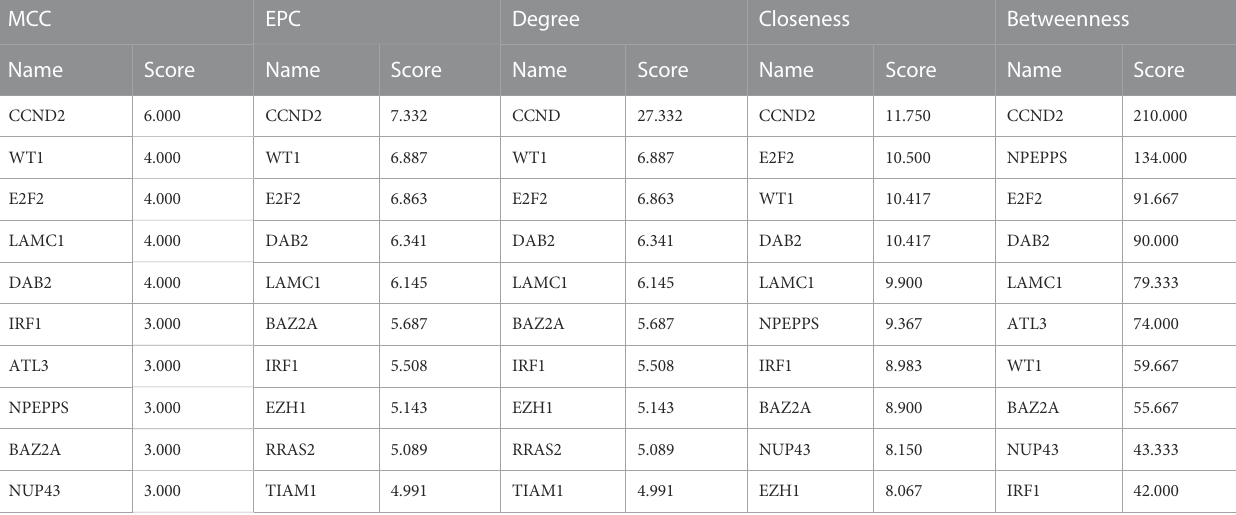
TABLE 2 Five methods of research subjects to screen the top 10 hub genes and their scores. MCC EPC Degree Closeness